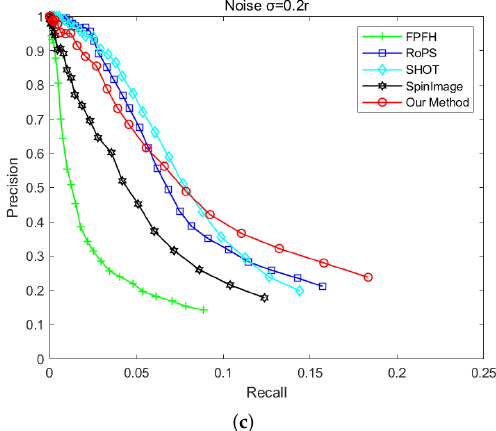
Figure 9. P − R curves in different noise scenes. ( a ) Gaussian noise σ = 0.05 r. ( b ) Gaussian noise σ = 0.1 r. ( c ) Gaussian noise σ = 0.2 r.